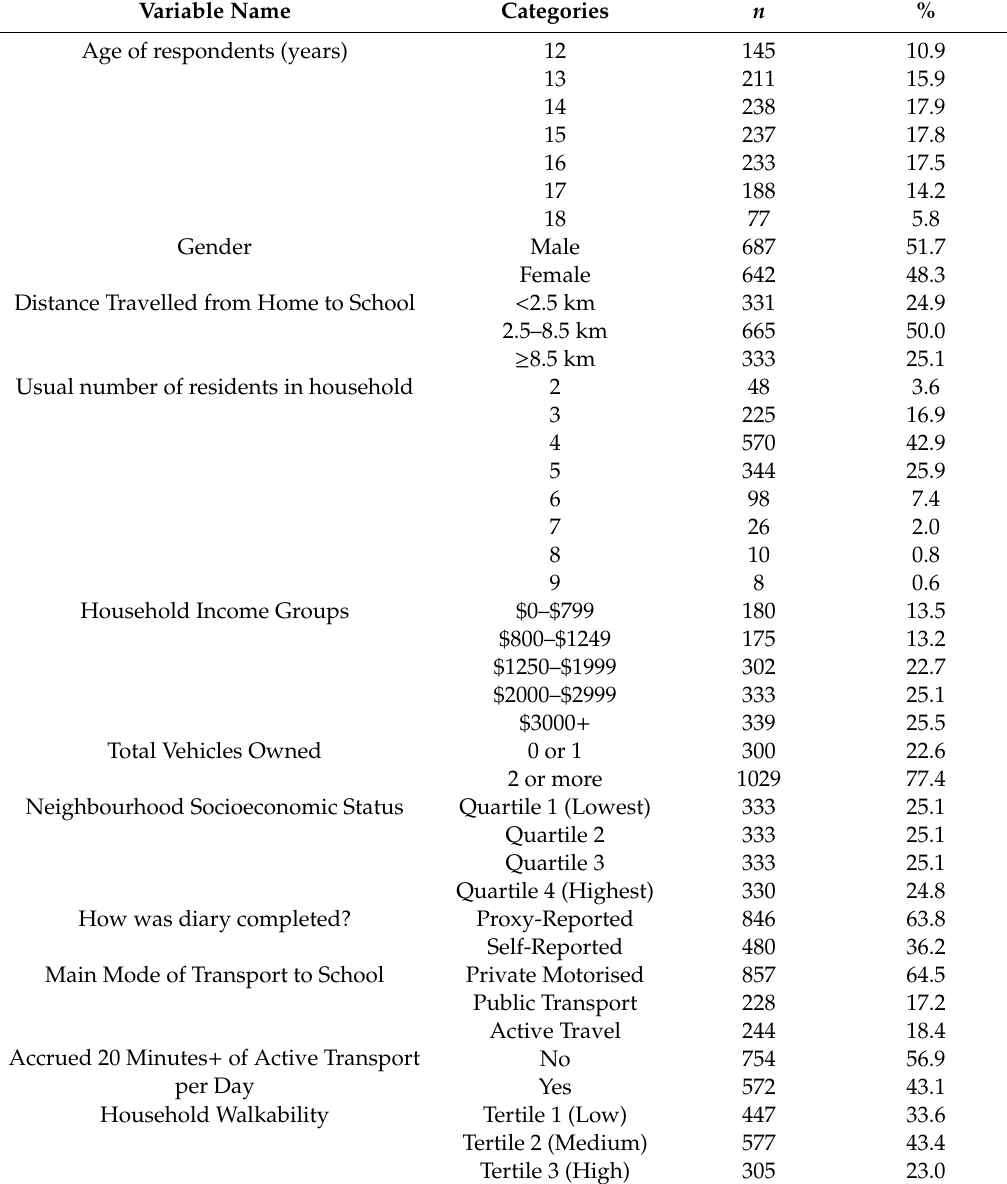
Table 1. Sample characteristics ( n =